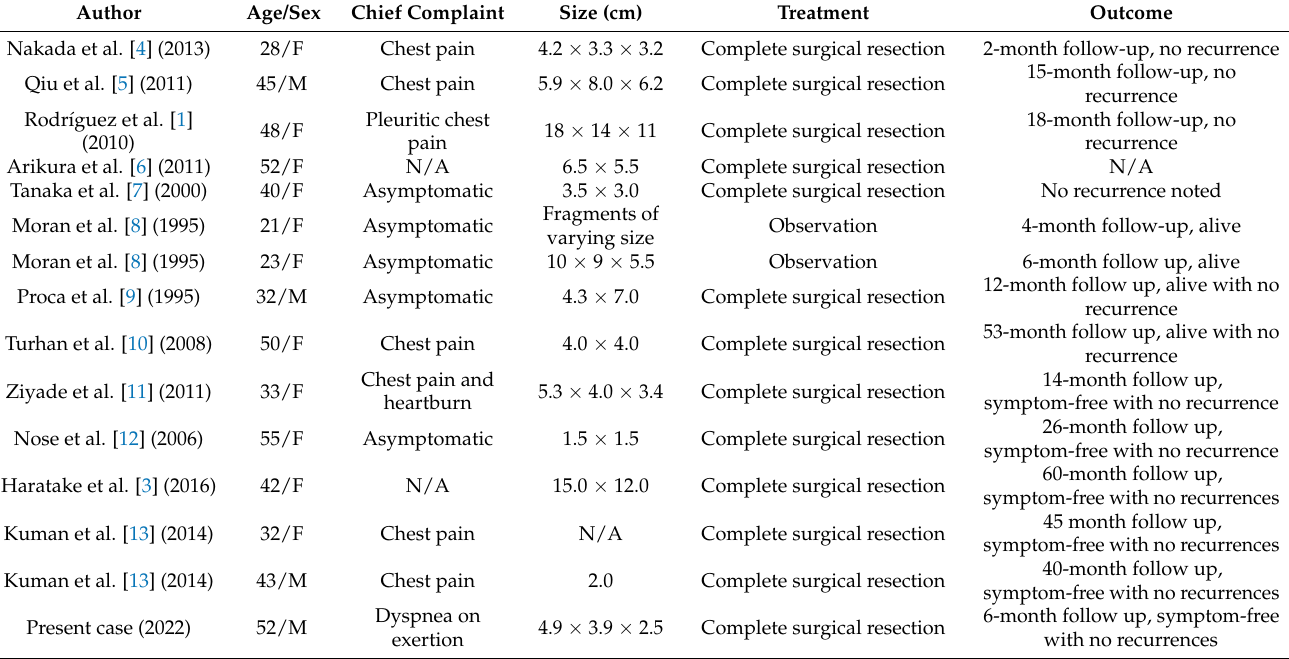
Table 1. Clinical features of reported extra-pleural leiomyoma Table 1. clinical features of reported extra-pleural leiomyoma cases.